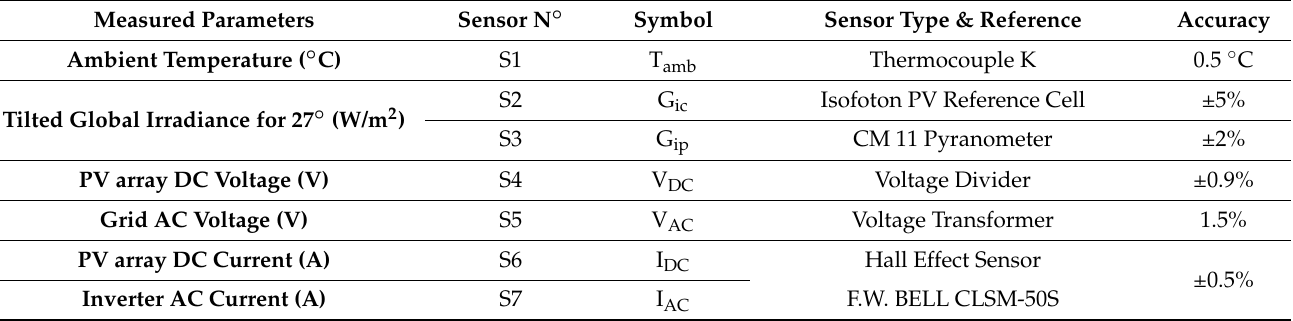
Table 3. Measured parameters of the PV inverters Fronuis IG 30 under nominal operating